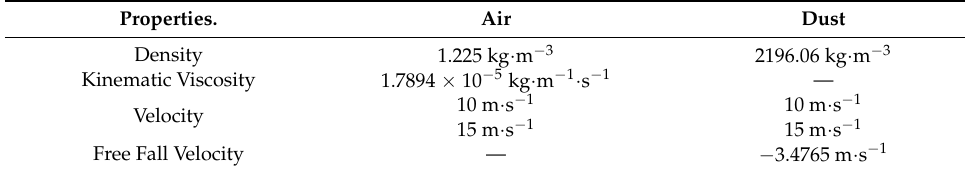
Table 4. Properties of air and dust used for the computational procedure.